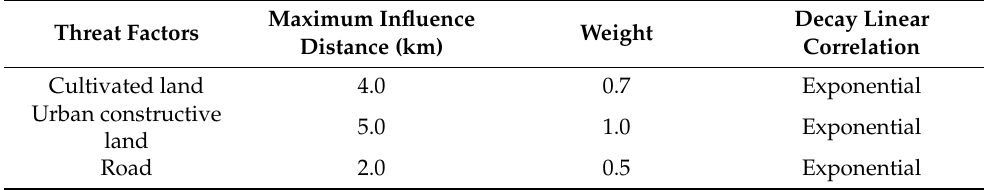
Table 1. Attributes of the threat factors.